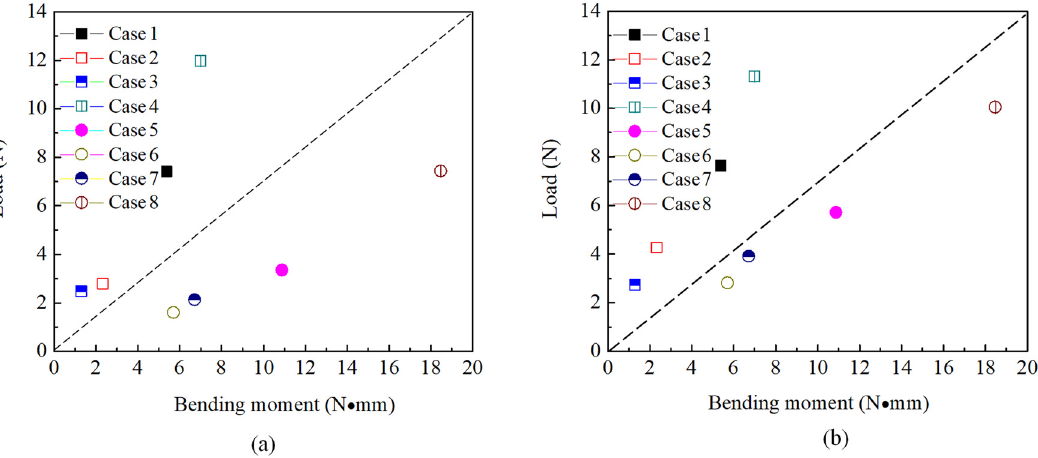
Figure 6: Combination diagrams of the bending moment at bending angle of 30° and compression load at the 30% ( a ) and 50% ( b ) deformation of the original